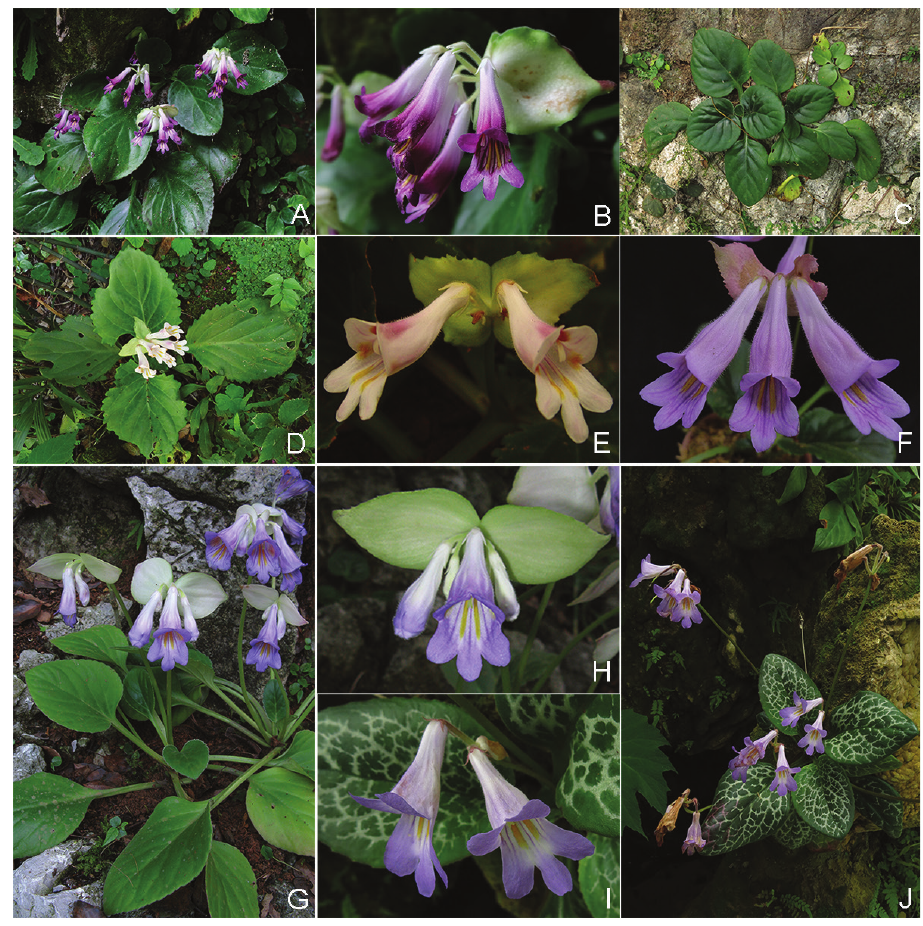
Figure 3. Primulina maguanensis ( A, B ), P. lungzhouensis ( D, E ), P. beiliuensis var. fimbribracteata ( C, F ), P. beiliuensis var. beiliuensis ( G, H ) and P. maculata ( I, J ). ( A, C, D, G, J ) habit, ( B, E, F, H, I ) flower. Photographs by Fang Wen ( A–H ) and Li-Hua Yang ( I, J